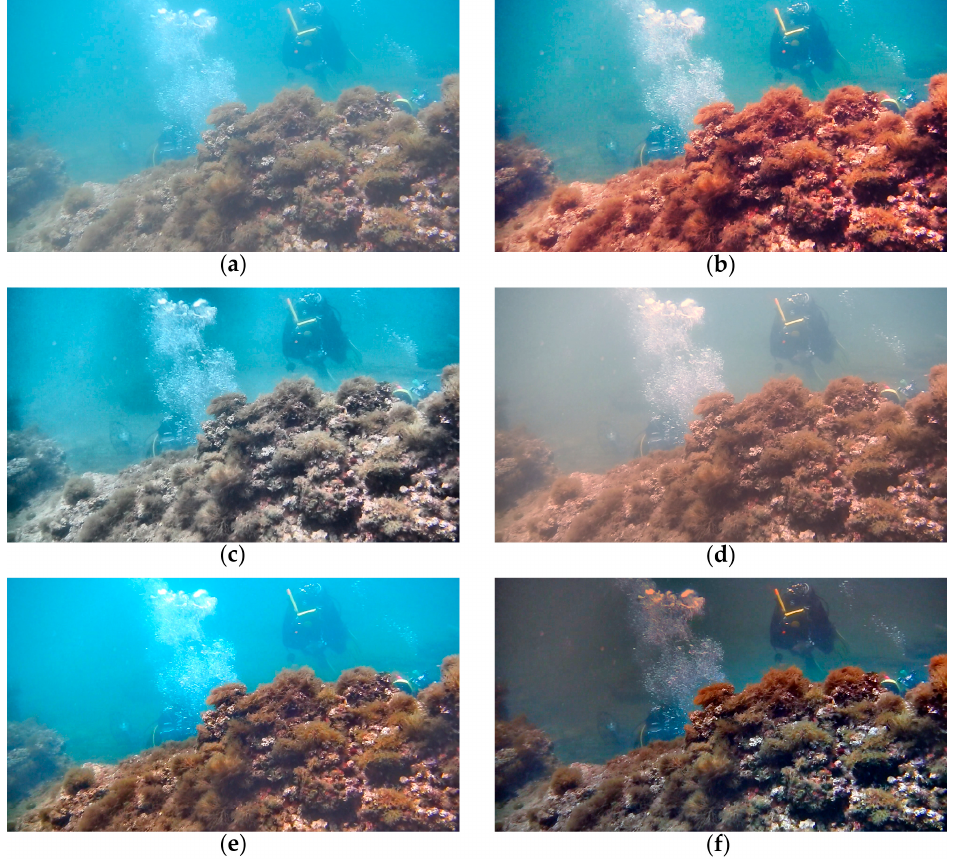
Figure 2. The image “Baia1” enhanced with all five algorithms. ( a ) Original image; ( b ) Enhanced with ACE; ( c ) Enhanced with CLAHE; ( d ) Enhanced with LAB; ( e ) Enhanced with NLD; ( f ) Enhanced with SP.